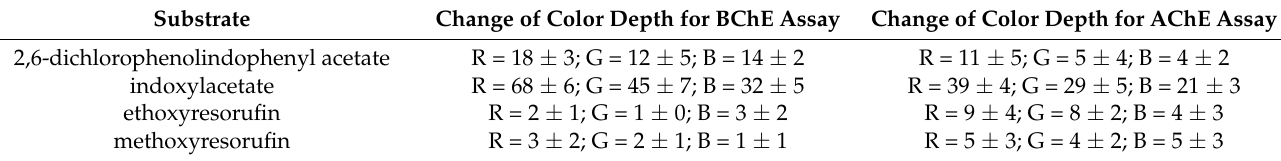
Table 1. Changes of color depths for acetylcholinesterase (AChE) and butyrylcholinesterase (BChE) assay 1 . Substrate Change of Color Depth for BChE Assay Change of Color Depth for AChE Assay 2,6-dichlorophenolindophenyl